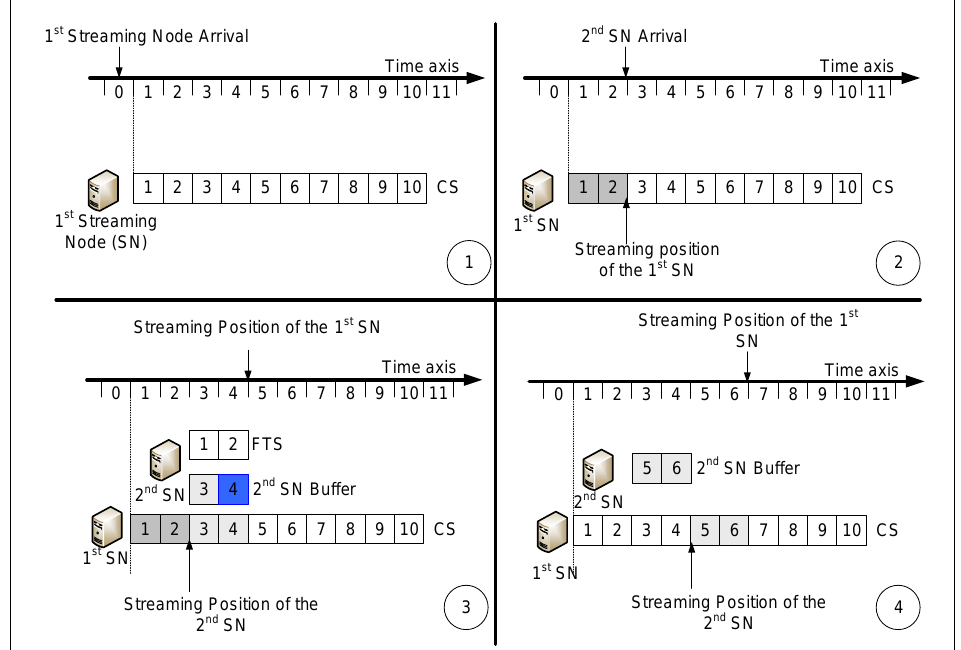
Figure 2. Illustration of the SST principle and how it handles late requests. In ( 1 ) the first SN request arrives and gets a CS. In ( 2 ) the second SN request arrives late for two slots. In ( 3 ) the Streaming node opens a FTS for the second SN to get the two missed slots while sharing the CS with first SN. In ( 4 ) the FTS is closed and the second SN continues getting the video from its